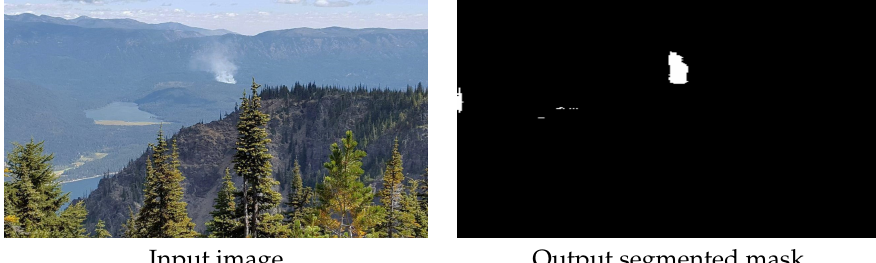
Figure 7. Example of segmentation of small smoke area by the proposed